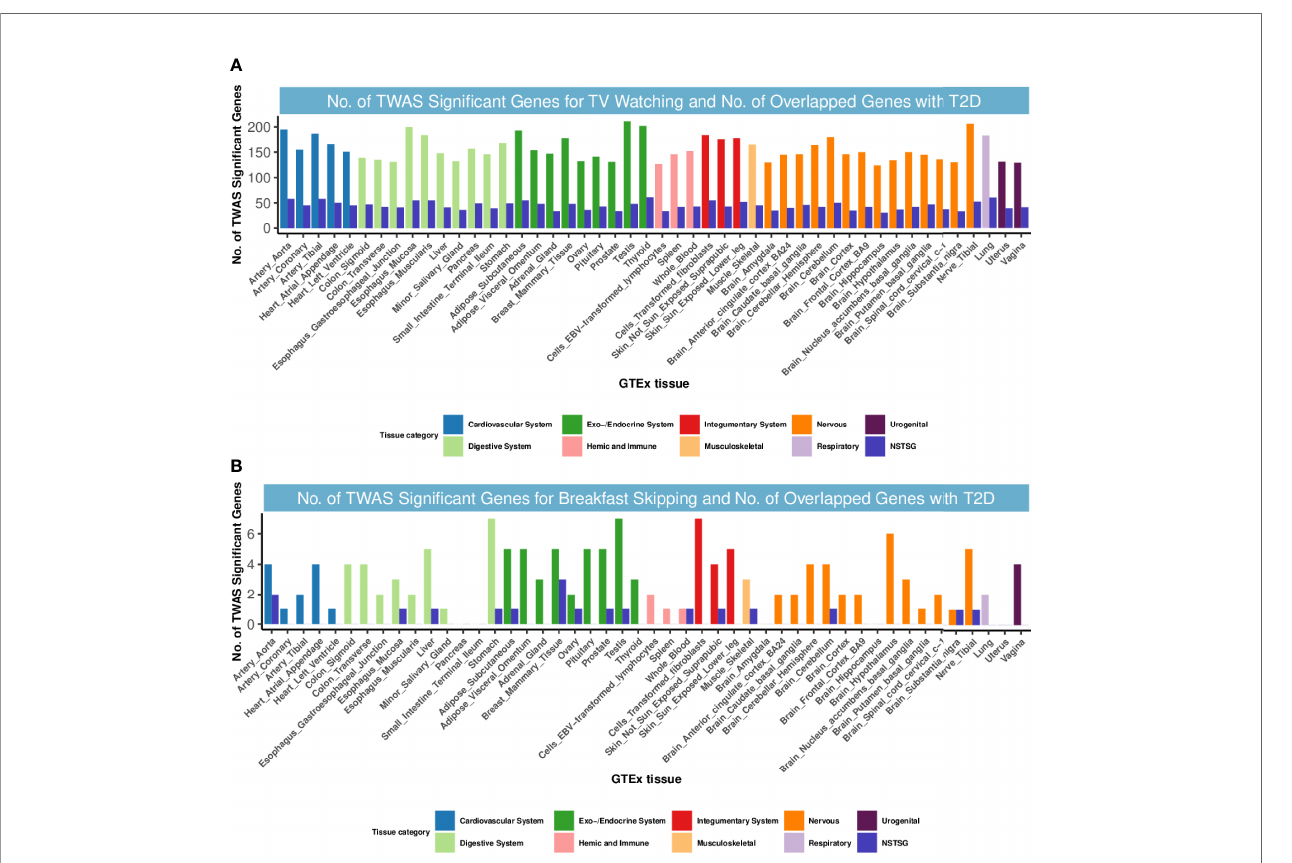
FIGURE 2 | Numbers of signi fi cant genes related to TV watching and breakfast skipping and the number of shared genes with T2D. Signi fi cant genes were identi fi ed by P Bonferroni < 0.05. GTEx, genotype-tissue expression project; GWAS, genome-wide association studies; TWAS, transcriptome-wide association study; NSTSG, Number of shared TWAS signi fi cant genes between traits; T2D: type 2 diabetes. (A) No. of TWAS Signi fi cant Genes for TV watching and No. of Overlapped Genes with T2D. (B) No. of TWAS Signi fi cant Genes for breakfast skipping and No. of Overlapped Genes with